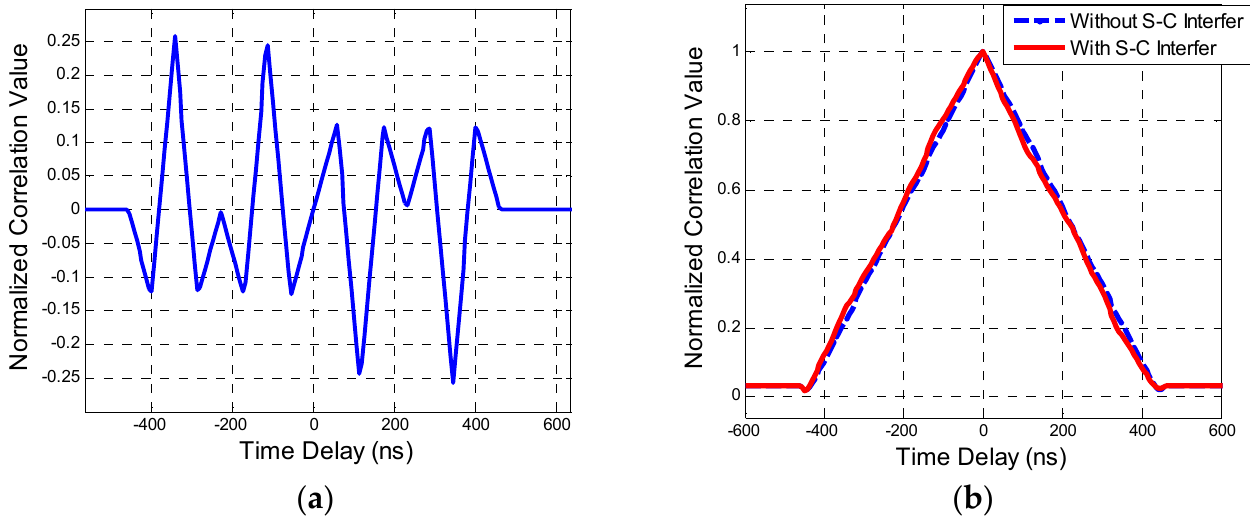
Figure 2. ( a ) The S-C interference of s 1 ( t ) Q [ cos ( ω s t )] and s 1 ( t ) Q [ cos ( ω s t )] · Q [ sin ( ω s t )] ; ( b ) The influence of S-C interference on the correlation curve.